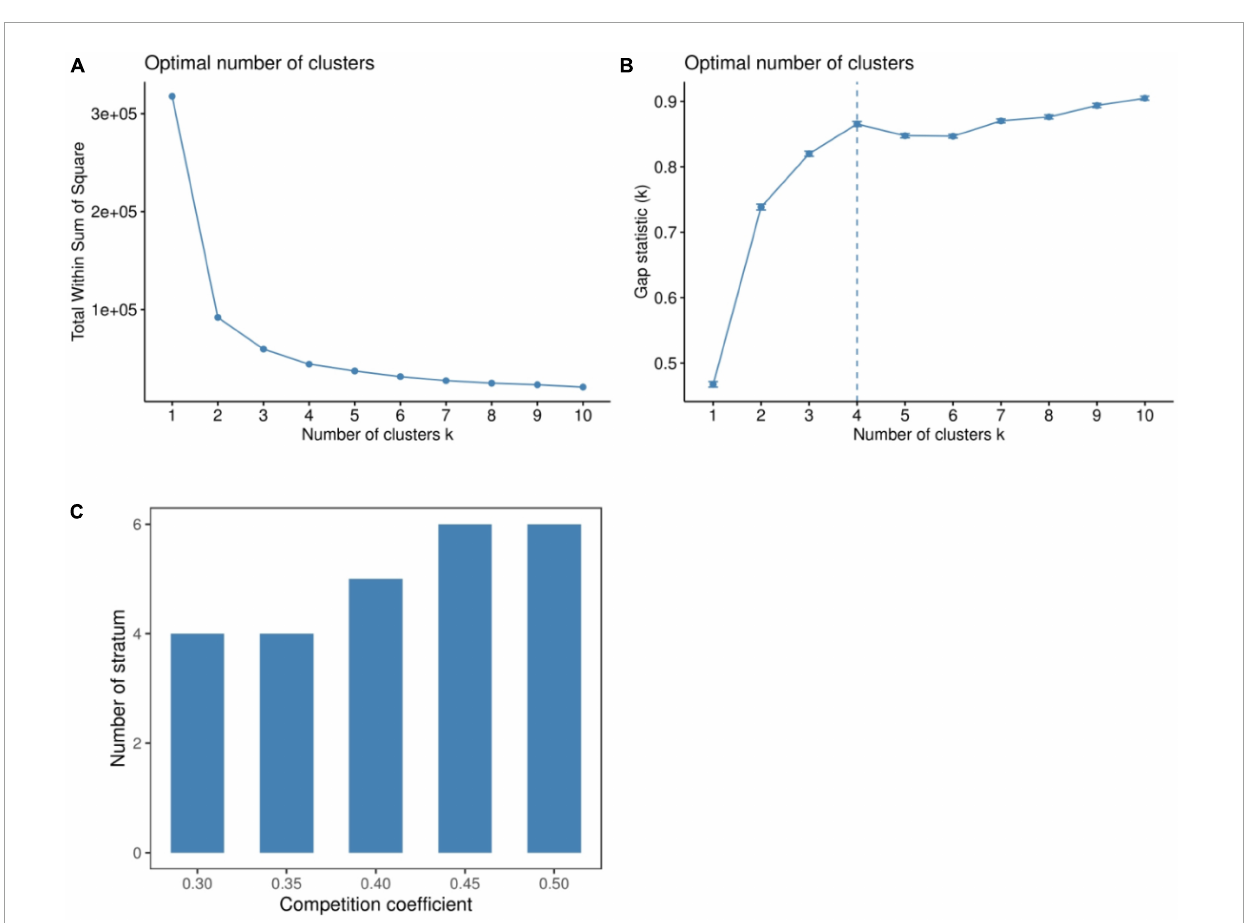
FIGURE1 Results of the sum of squares (A) , gap statistics (B) , and TSTRAT algorithm (C) .